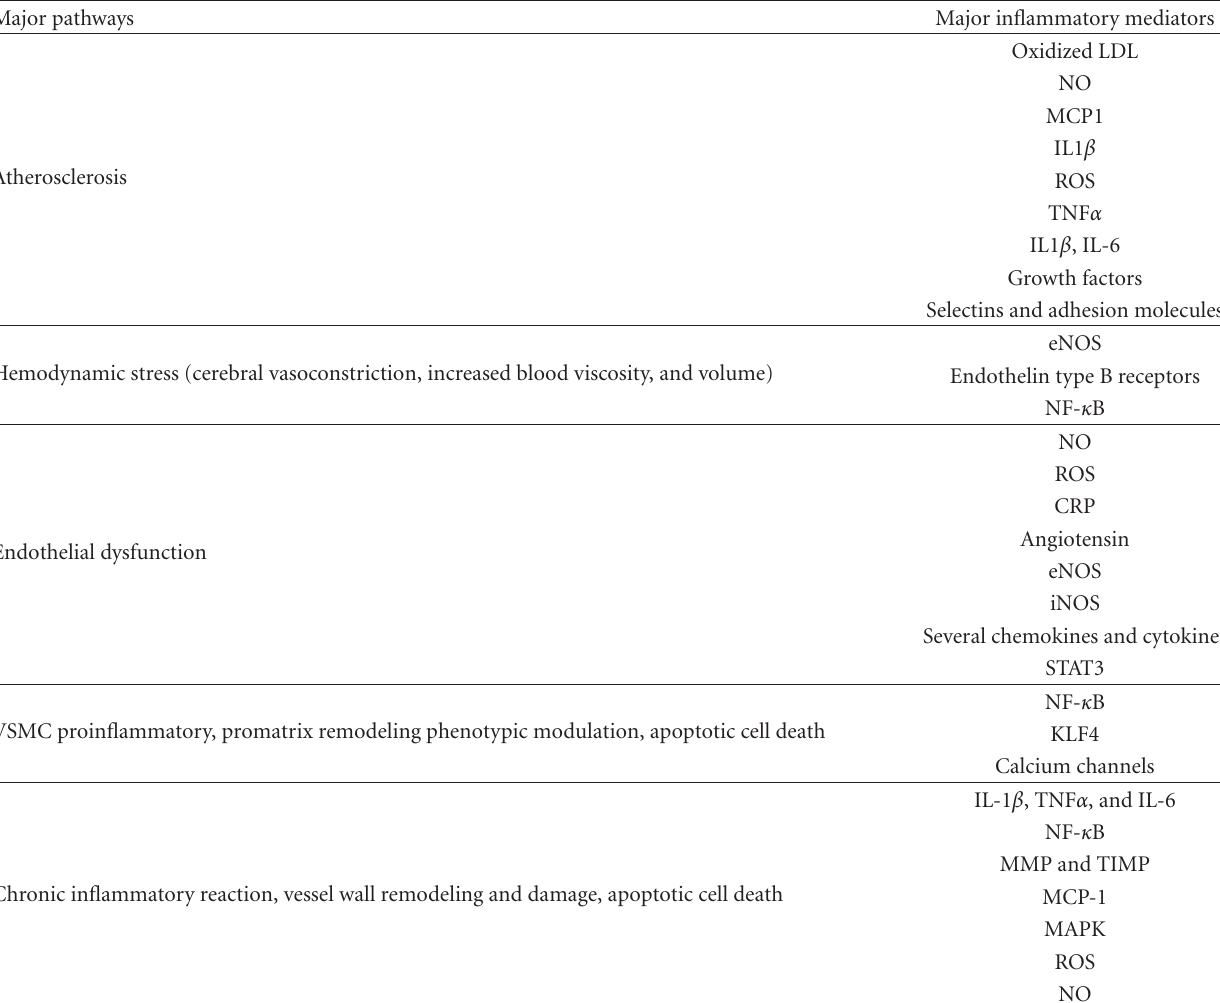
Table 1: Summary of major pathways and inflammatory mediators a ff ected by cigarette smoke exposure and involved in aneurysm